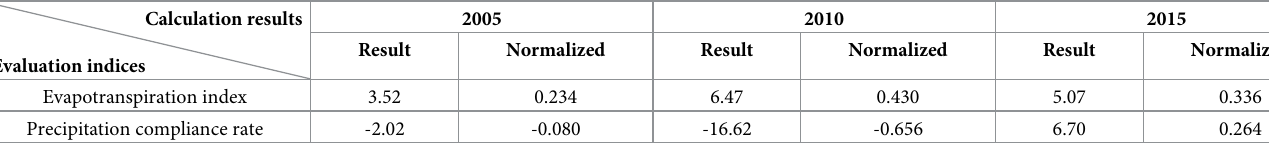
Table 8. The results of evapotranspiration index and precipitation compliance rate.